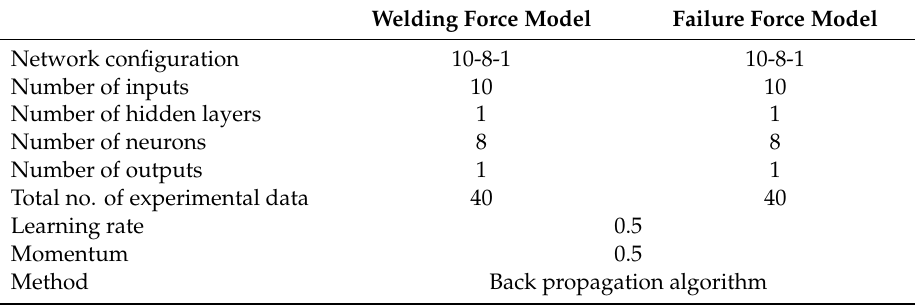
Figure 6. The architecture of artificial neural network (ANN) models in this paper. The architecture of the model for the downward axial force and fracture force was 10-8-1 for both of them. Table 4. The details regarding the developed ANN models in this paper to study the effect of tool geometry and process parameters on the downward axial force and failure force.